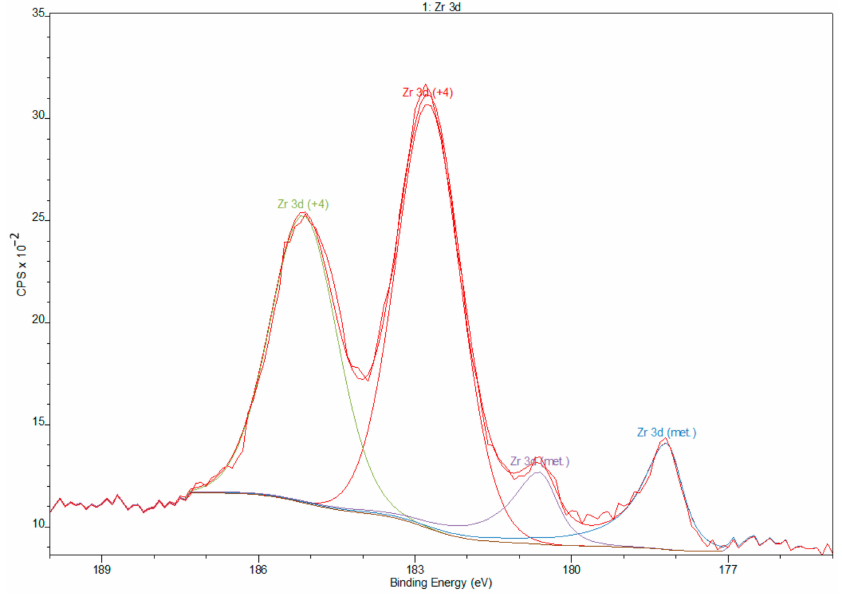
Figure 7. Deconvolution XPS spectra of